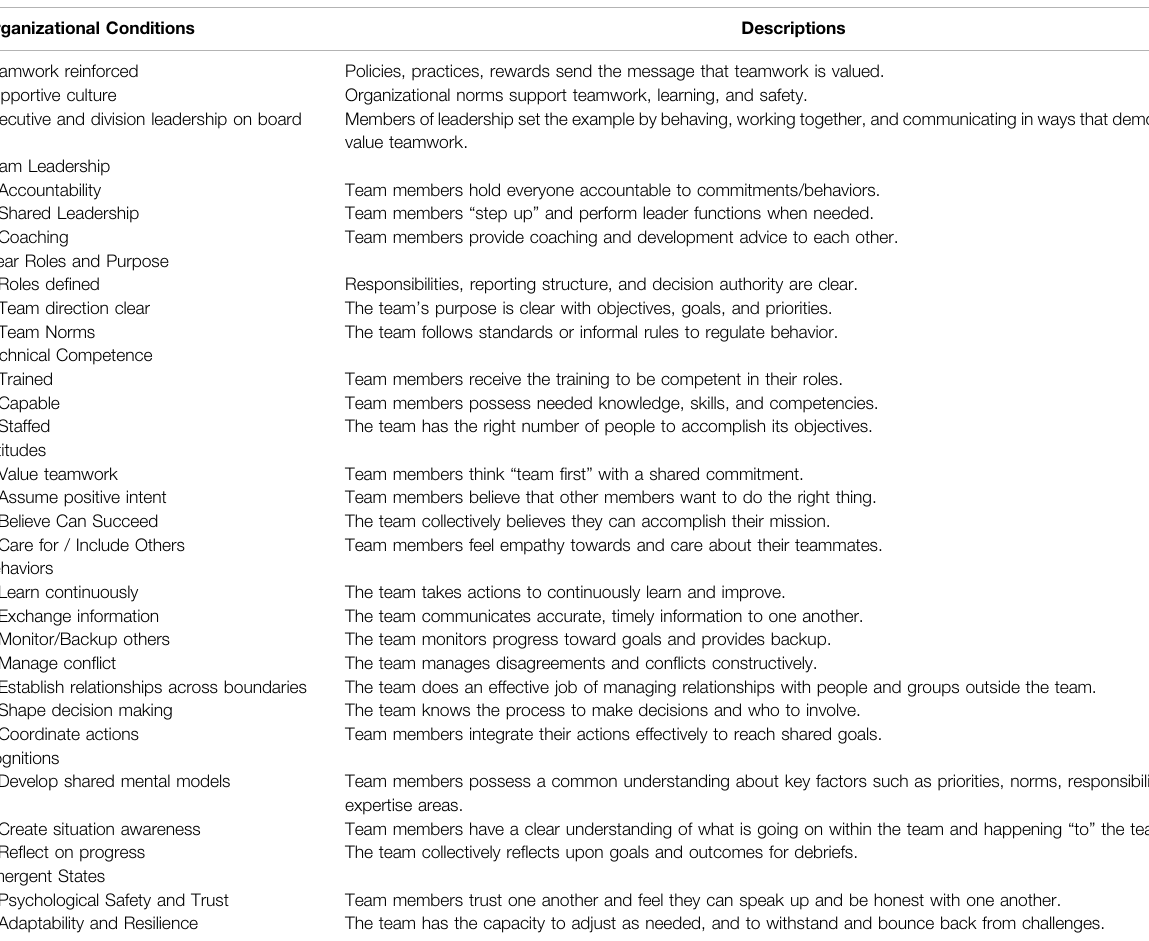
Table A1 | Framework Competency